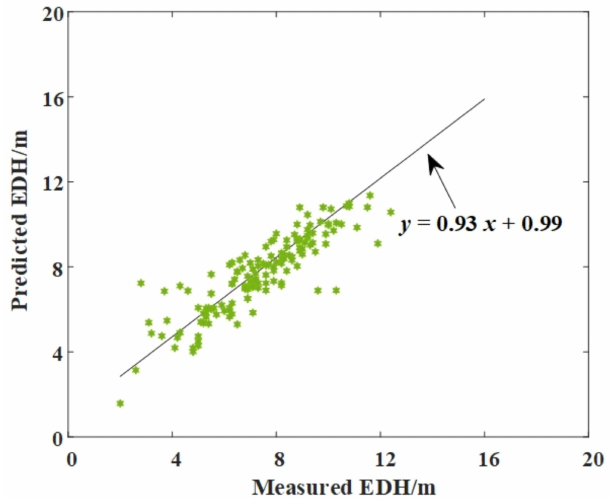
Figure 9. Scatter plot of measured EDH against modeled EDH using the multilayer-MLP-EDH